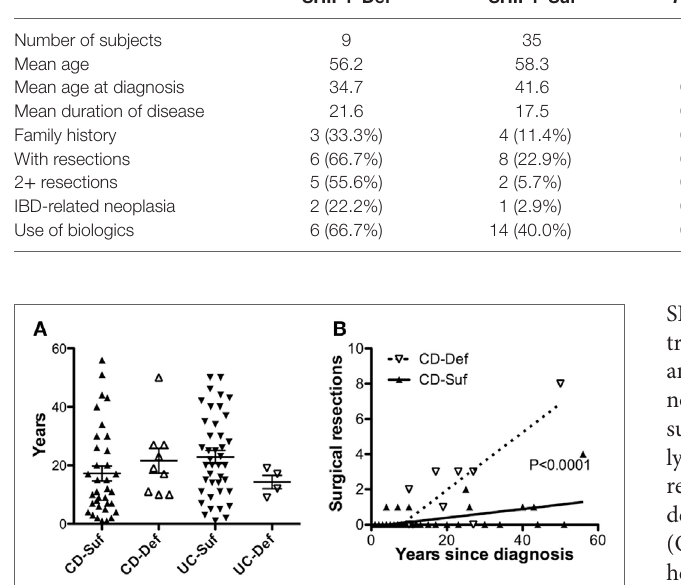
FigUre 2 | SHIP1-deficient Crohn’s disease (CD) subjects have a history of more severe disease that does not result from a longer duration of disease. (a) No differences were observed in the duration of disease at the time of enrollment between SHIP1-sufficient and SHIP1-deficient subjects with either disease subset. (B) Increased number of surgical resections is not due to a longer duration of disease in SHIP1-deficient CD patients (Linear regression analysis, P < 0.0001).